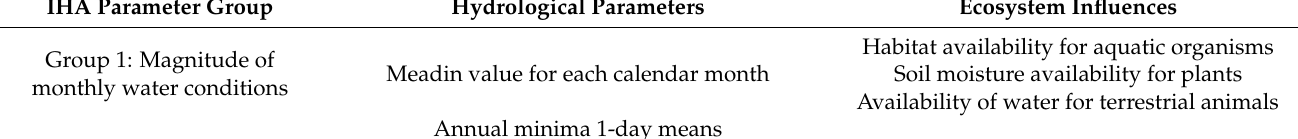
Table 2. IHA33-based indicators and related ecologically relevant